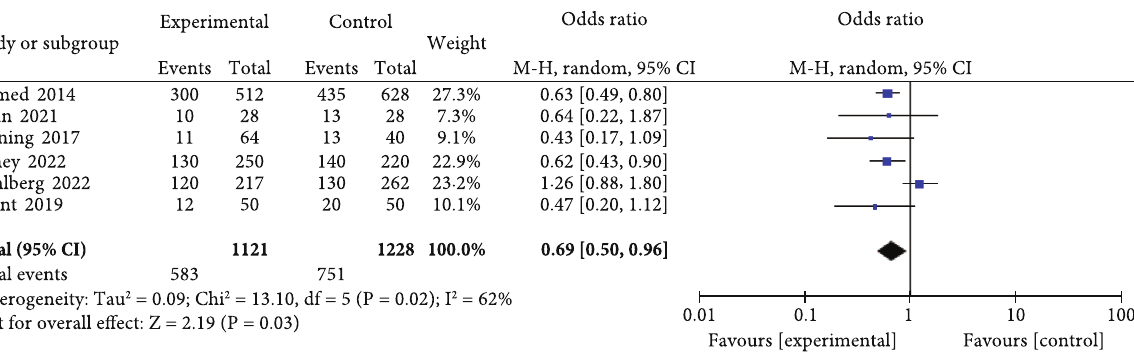
Figure 5: E ffi cacy of high-quality nursing on the incidence of agitation. P = 0 : 03 , ∗ . With heterogenity 0.09, Chi 2 = 13 : 10 , df = 5 , I 2 = 62 % .